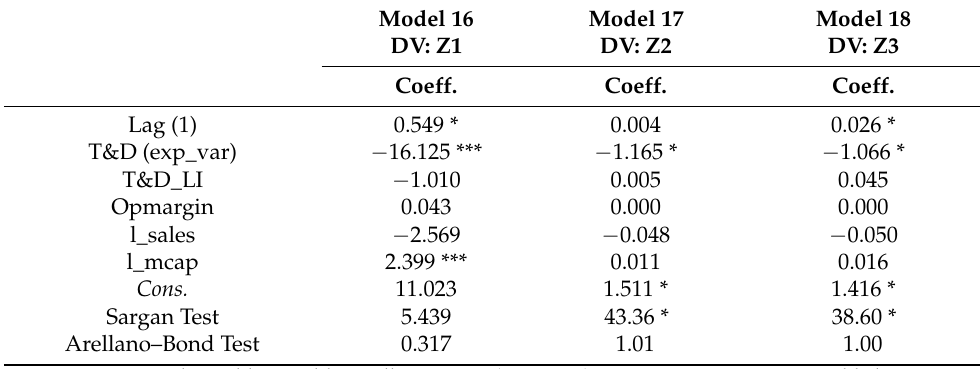
Table 9. Interaction Models (Dynamics Panel Data